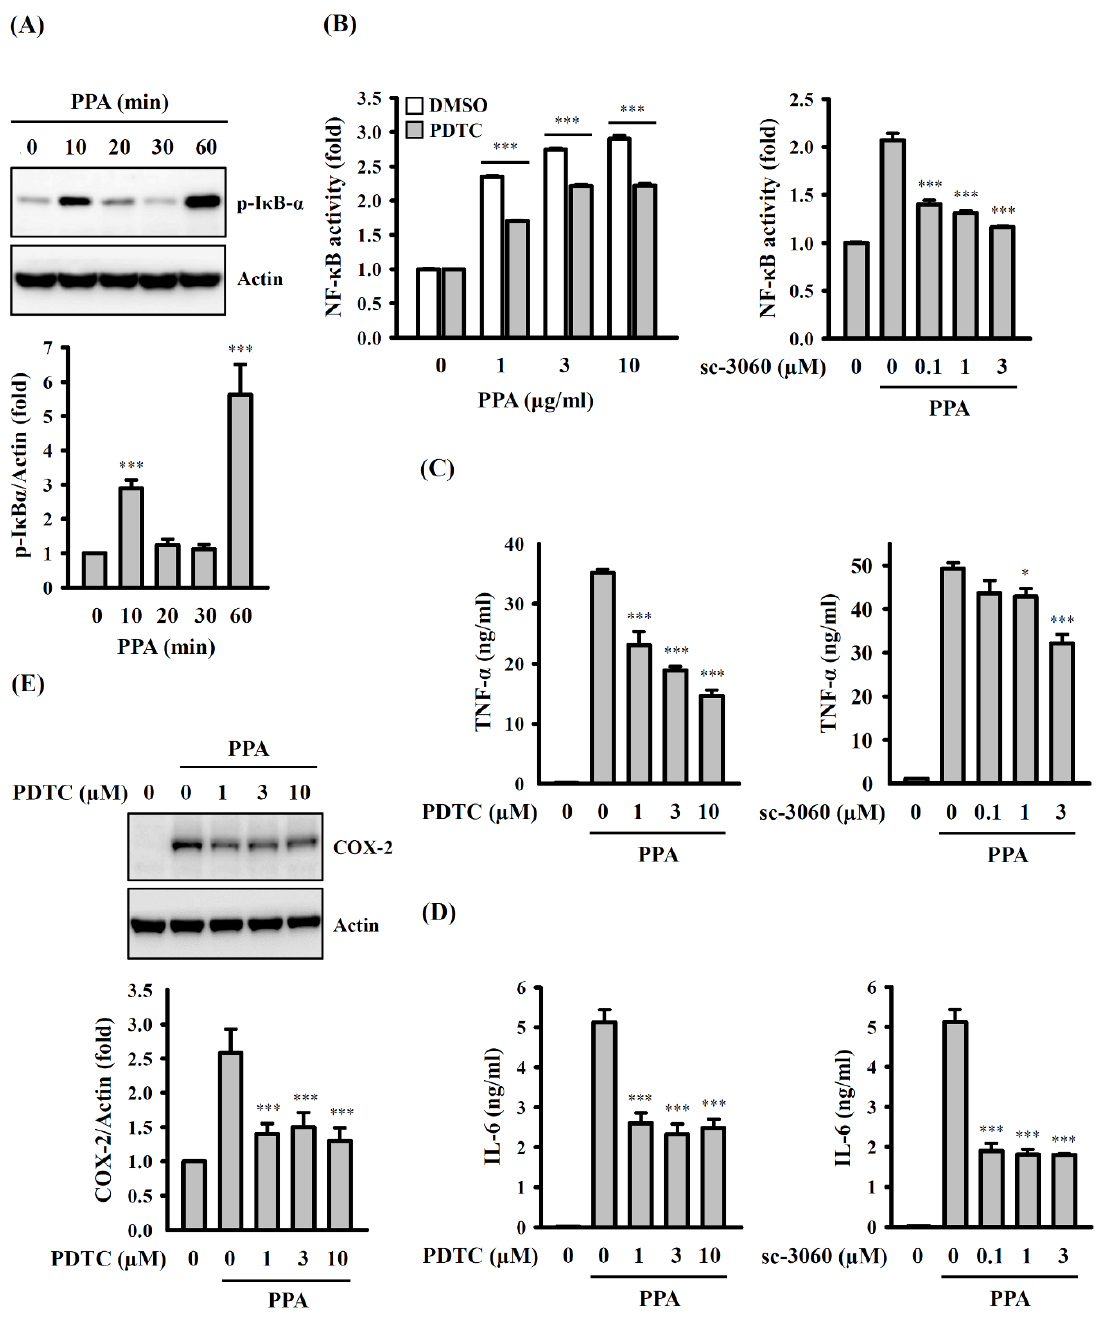
Figure 7. Effect of NF- κ B on PPA-induced TNF- α and IL-6 secretion and COX-2 expression. ( A ) The phosphorylation levels of I κ B- α in PPA-stimulated RAW264.7 macrophages. ( B ) Effect of PDTC or sc-3060 on NF- κ B activation in PPA-stimulated RAW-Blue cells. ( C – E ) Effect of PDTC or sc-3060 on ( C ) TNF- α, ( D ) IL-6 and ( E ) COX-2 in PPA-stimulated RAW264.7 macrophages. * p < 0.05 and *** p < 0.001 compared to control cells ( A ), PPA-treated cells ( B – E ), or as indicated (( B ), left panel).